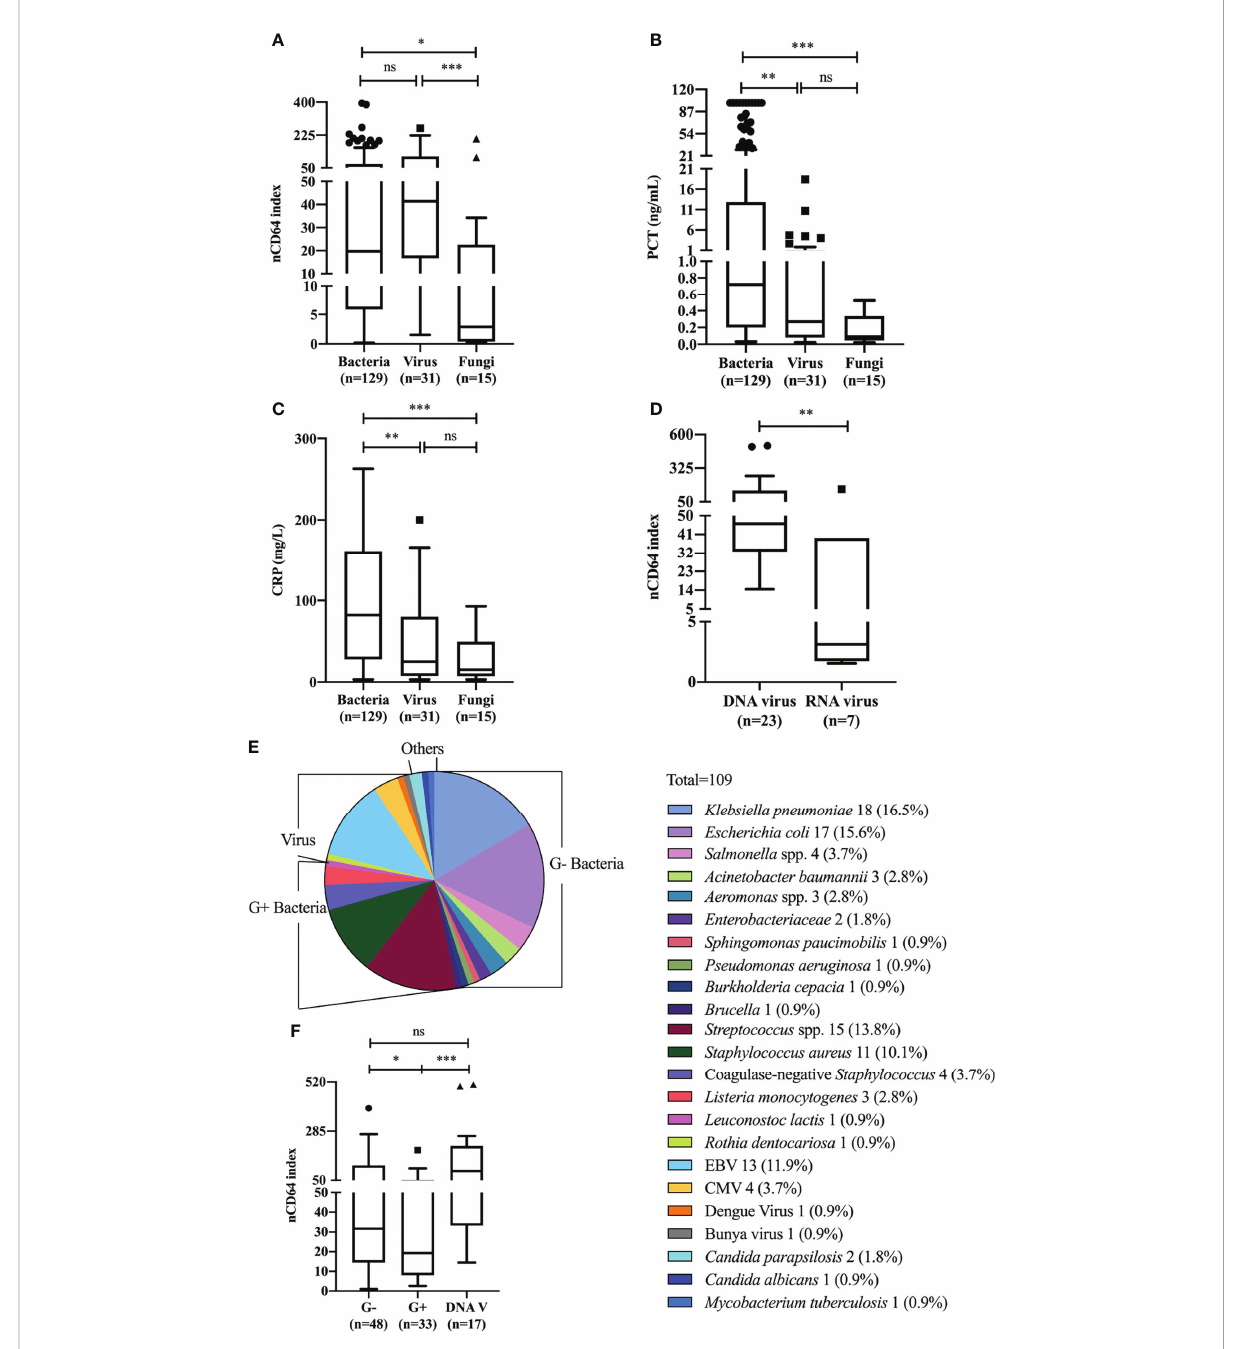
FIGURE 3 nCD64 index of different pathogens in patients with sepsis. Differences of nCD64 index (A) , PCT (B) , and CRP (C) in bacterial, viral and fungal infections. (D) The comparison of nCD64 index in DNA and RNA viral infections. (E) Microbial composition of blood samples in patients with bloodstream infections. (F) The comparison of nCD64 index in G-, G+ bacterial and DNA viral bloodstream infections. The comparisons of nCD64 index, PCT and CRP between independent groups were performed using Mann-Whitney U test (two groups), and Kruskal-Wallis test (multiple groups) followed by Dunn ’ s post-test for multiple comparisons. * P <0.05, ** P <0.01, *** P <0.001. nCD64, neutrophil CD64; PCT, procalcitonin; CRP, C-reactive protein; DNAV, DNA virus; EBV, Epstein Barr virus; CMV, cytomegalovirus; ns, no signi fi